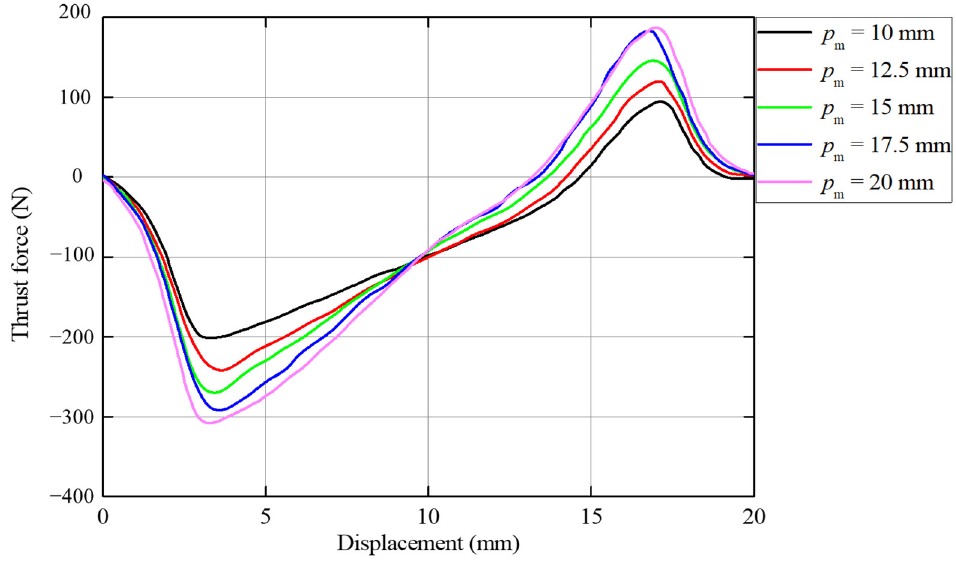
Figure 8. Variation in thrust force with thickness of windings p m .